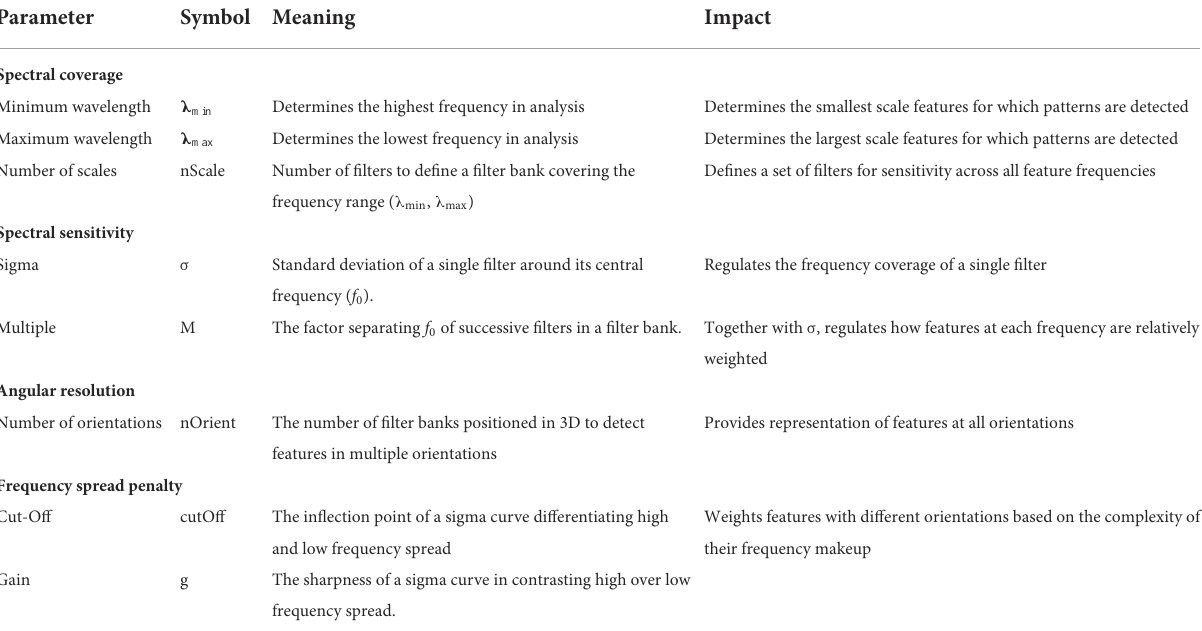
TABLE 1 Definition and impact of phase congruency